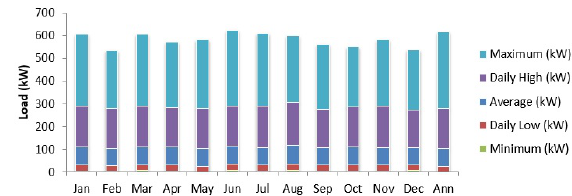
Figure 3: Seasonal load profile